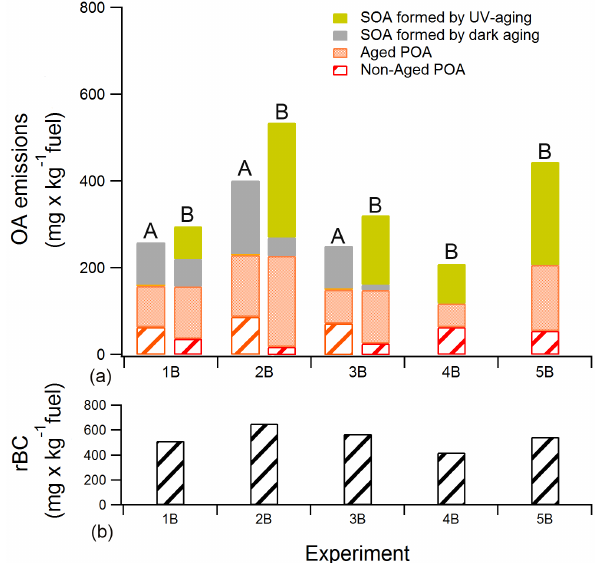
Figure 6. Aged and non-aged POA emission together with SOA at the end of dark (a) and UV aging (b) periods based on PMF calculations (Exp. 1B-5B) as well as (b) refractory black carbon (rBC) emissions.